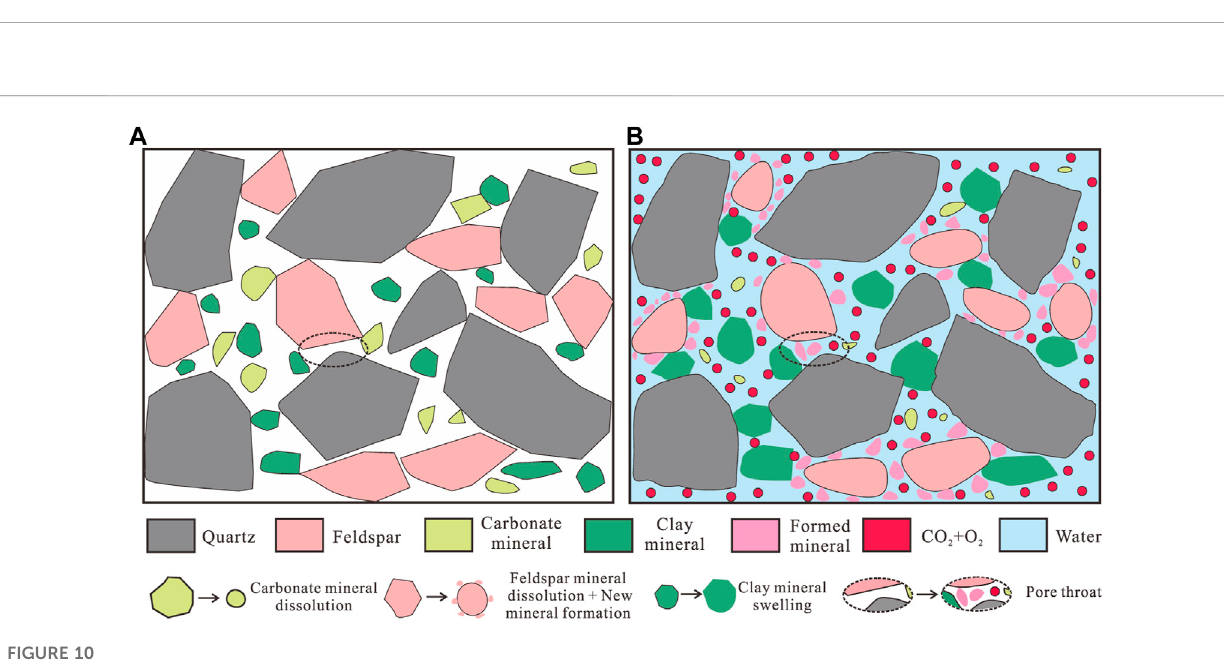
FIGURE 9 SEM images showing the reconstruction effect of the CO 2 + O 2 – water – rock geochemical reaction on pore morphology. (A) Before the CO 2 + O 2 – water – rock geochemical reaction; (B) after the CO 2 + O 2 – water – rock geochemical reaction.